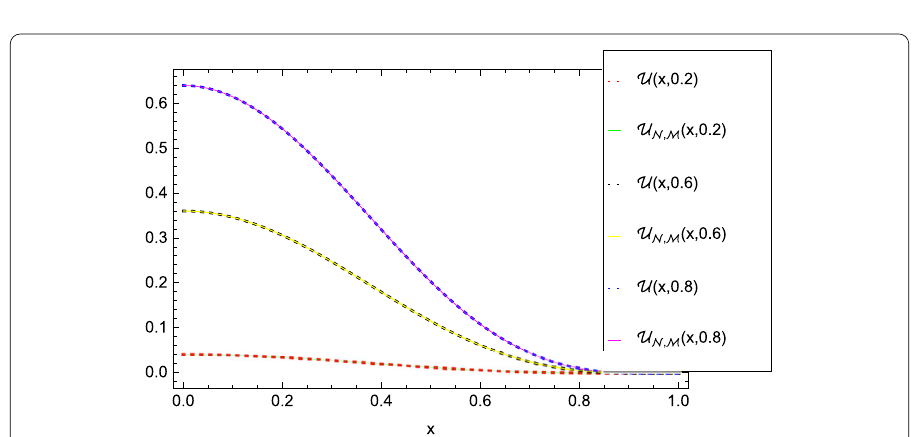
Figure 3 x -direction curves of U and U N , M of problem (1) with δ = 1.8, N = 8, M =